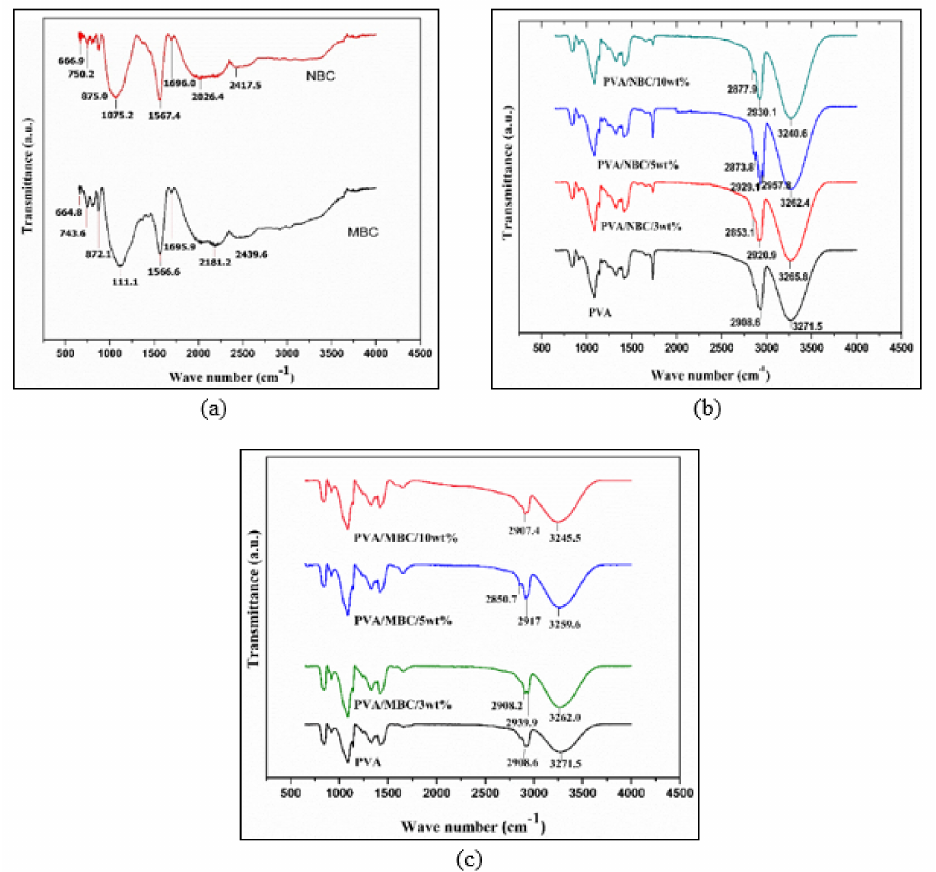
Figure 22. FTIR spectra of ( a ) NBCs and MBCs particles, ( b ) PVA–NBC nanocomposites, and ( c ) PVA–MBC nanocomposites